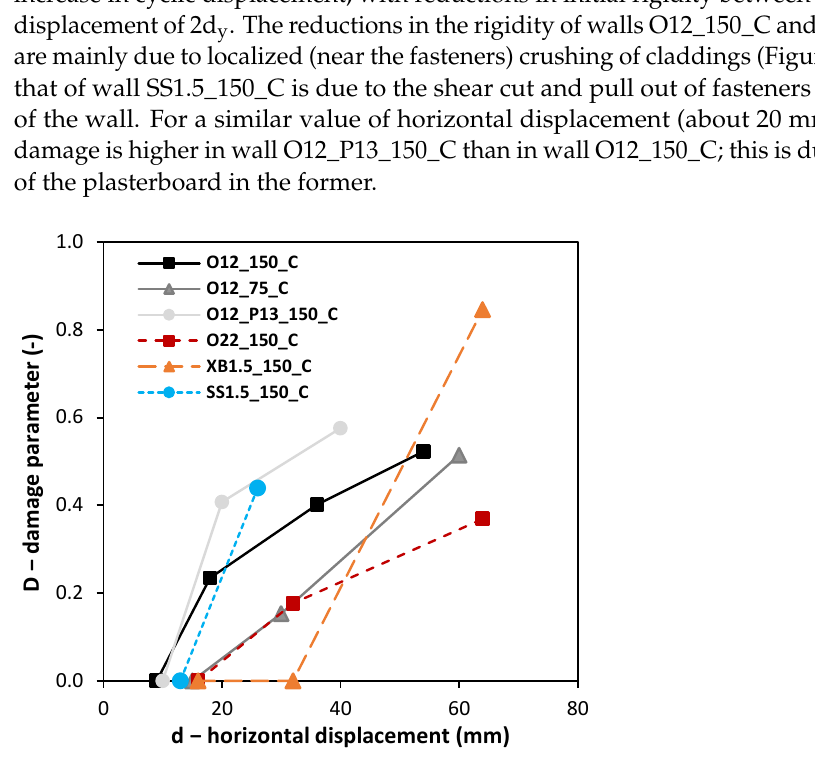
Figure 6. Evolution of the damage parameter, D, with the increase in horizontal displacement, d, for the walls tested under cyclic loading.